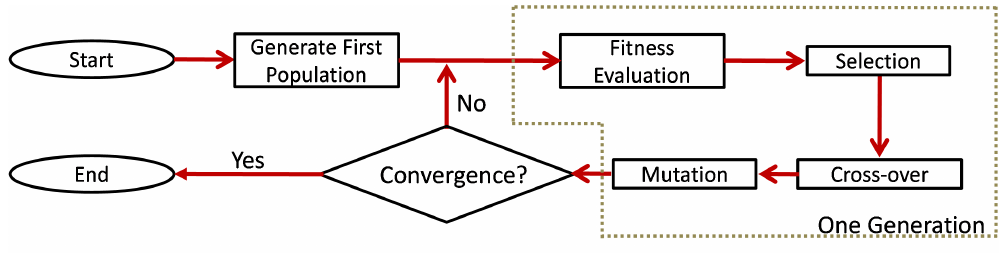
Figure 3. Framework of the simple genetic algorithm (GA) [25].